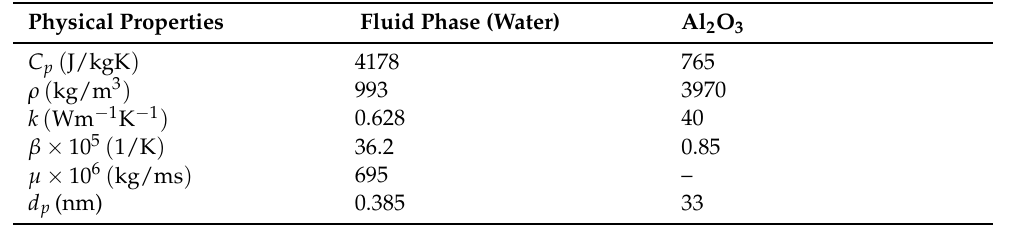
Table 2. Thermo-physical characteristics concerning pure liquid (water) and Al 2 O 3 nanoparticles at T = 310 K